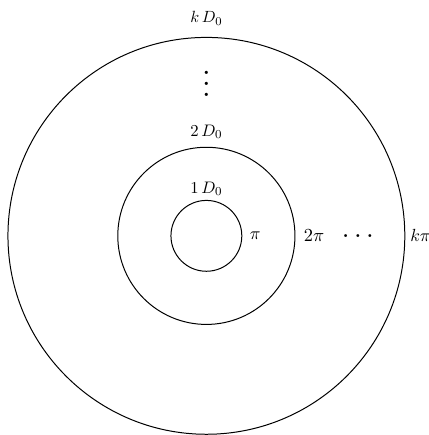
Figure 3 . Concentric distribution of expanded D0-branes on 2-spheres with radii (cid:26) = k(cid:25) . At each radius k(cid:25) there are N 2 = L 4 k coincident 8 (cid:11) 0 2